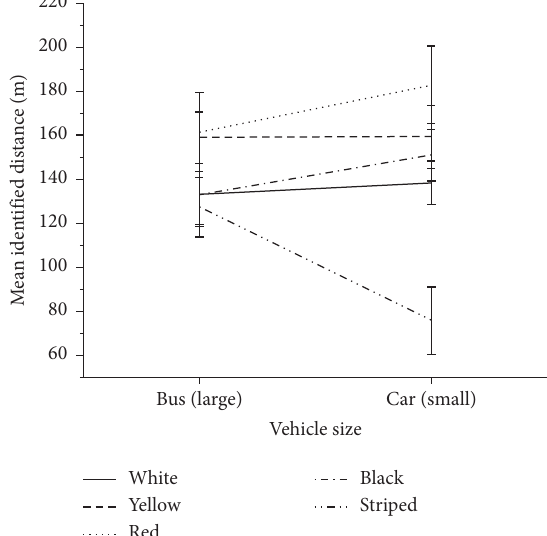
Figure 6: Interaction effects of vehicle size and vehicle color.